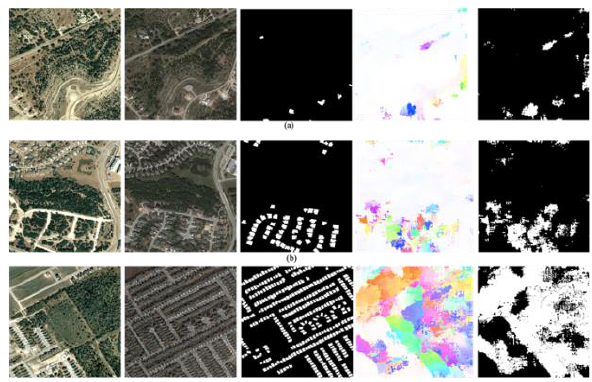
Figure 6. SIFT results for two pairs of images from the dataset. (a) shows the first pairs results and (b) shows the second pair. (c) shows the third pair. For each pair the first two images are the multitemporal pair, the third image is ground truth, the fourth image is the flow vector field resulting from SIFT flow and the last image is the change map obtained by thresholding the flow field. To put the visual results of SIFT flow-based change detection, Figure 7, contains the visual results of two other models alongside it. The first row of images in this Figure 7, are the input image pair and their ground truth. The second row shows the results of PCA-Kmeans in (d), CEECNet in (f) and SIFT flow- based change map in